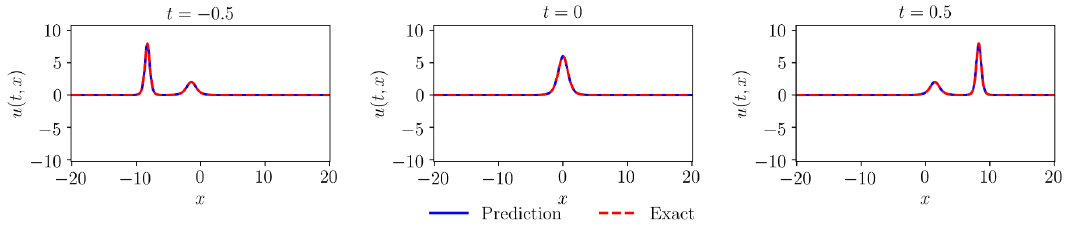
Figure 7. Two-soliton solution of the KdV equation given by physics-informed neural networks.